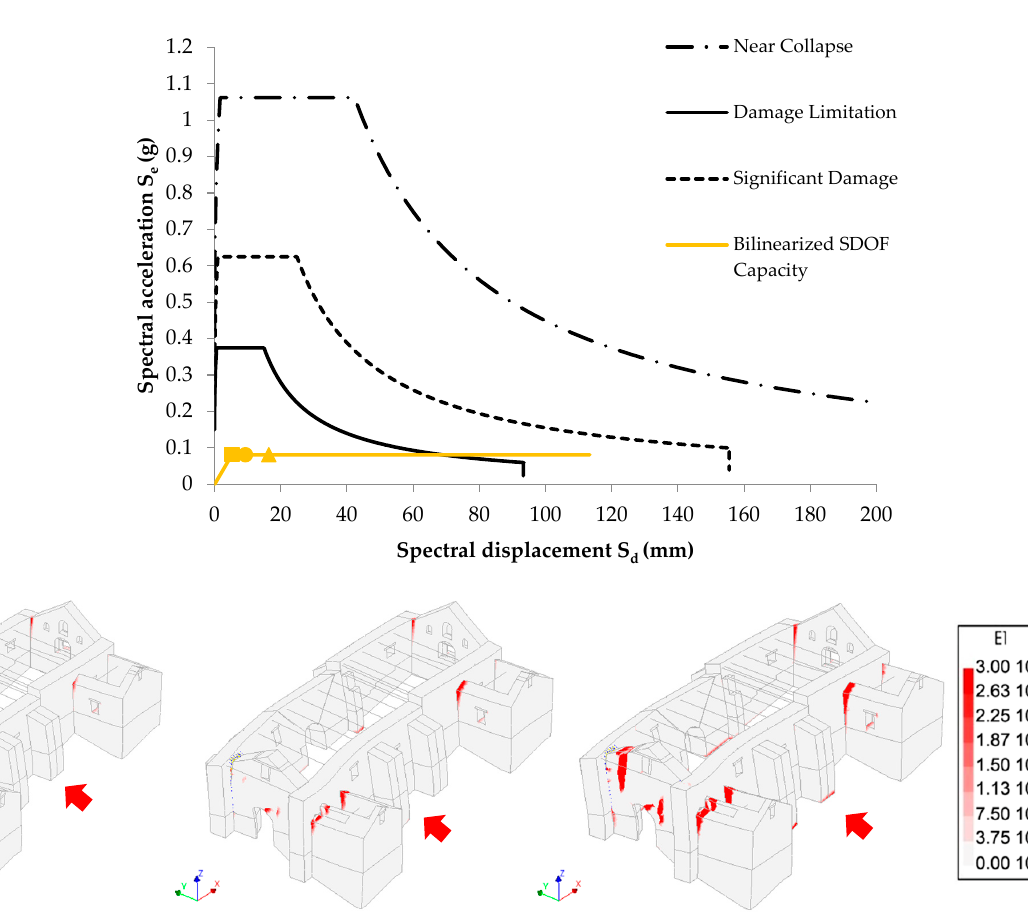
30 of 36 Table 9. Data used to obtain target displacement of MDOF system for different performance limit states. Direction Assumed Shape